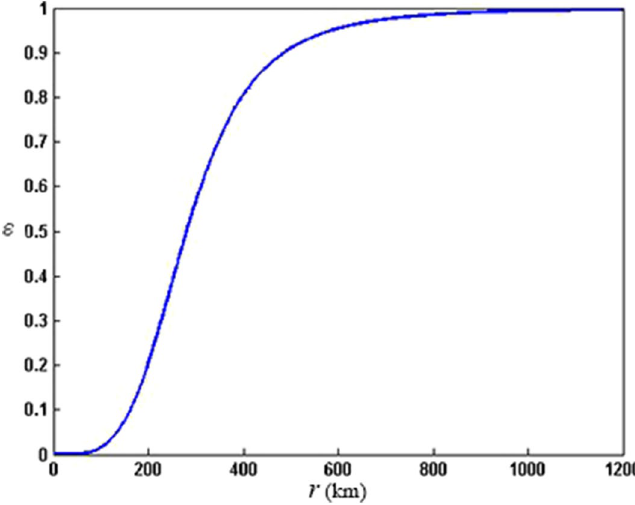
Figure 1. ε varies with r